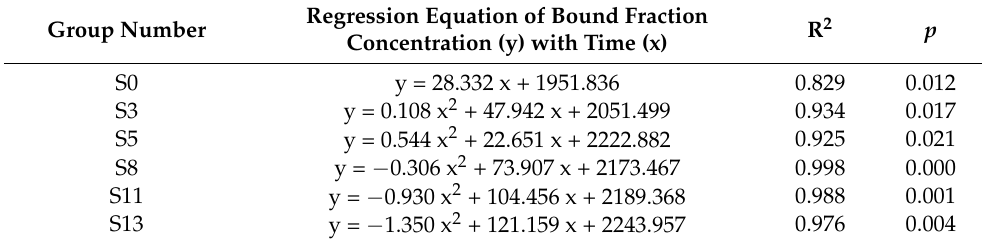
Table 6. Regression equation for concentration change of the bound fraction.